Question: Produce a descriptive caption suitable for publication.
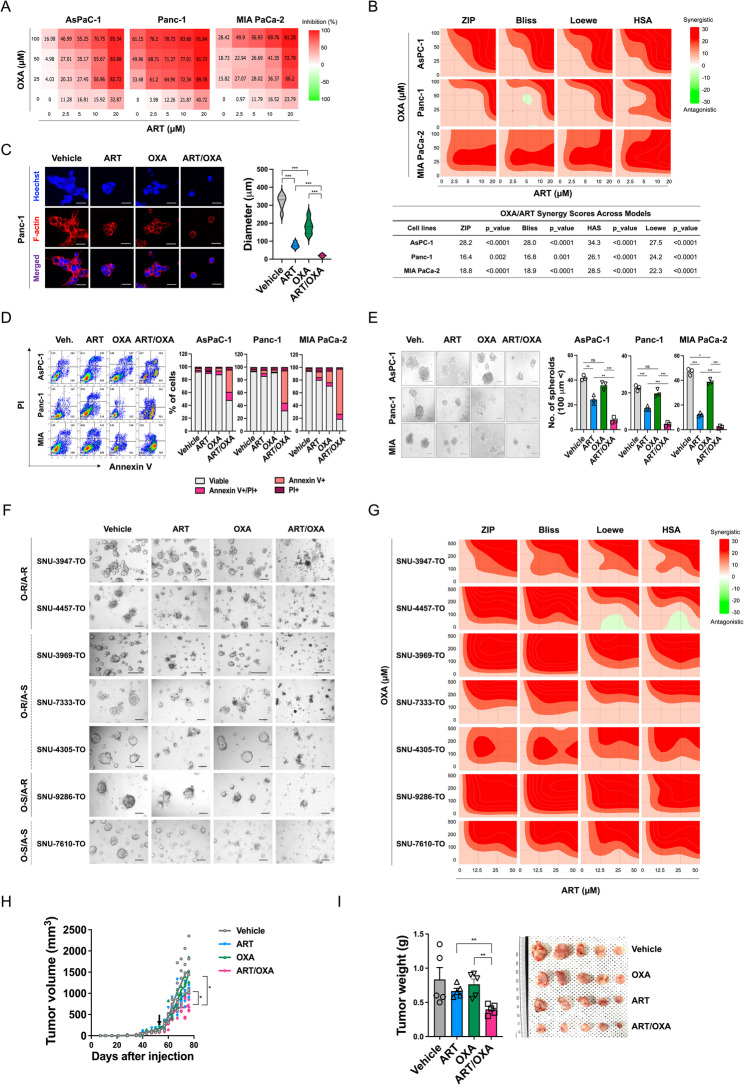
Answer: Oxaliplatin and artesunate synergize to suppress cancerous effects pancreatic cancer growth in vitro and in vivo. A Cell viability matrices showing the dose-dependent effects of OXA (0–100 µM) and ART (0–20 µM) combinations on AsPC-1, Panc-1, and MIA PaCa-2 cells over 48 h. The color scale indicates percent inhibition. B Synergy maps for OXA/ART combinations generated using ZIP, Bliss, Loewe, and HSA scoring, with corresponding synergy and statistical significance scores. C Representative images and quantification of cancer cell metastasis in 3D Matrigel models treated with vehicle, OXA (100 µM), ART (10 µM), or their combination for 48 h (nuclei: blue; F-actin: red). D Annexin V/PI flow cytometry shows cell death profiles following 48-h treatment with vehicle, OXA (100 µM), ART (10 µM), or combination. Representative flow cytometry plots and quantification of viable, early apoptotic, and late apoptotic/necrotic populations. E Spheroid formation capacity in 3D culture after 5-day treatment with vehicle, OXA (50 µM), ART (5 µM), or combination, with representative phase-contrast images and quantification. F Representative phase-contrast images of PDPCOs treated with the vehicle, ART (10 µM), OXA (200 µM), or combination for 5 days. G Synergy maps for OXA (0–500 µM) and ART (0–50 µM) combinations treated for 5 days across multiple PDPCOs analyzed using SynergyFinder 2.0. Four different synergy scoring models (ZIP, Bliss, Loewe, and HSA) were applied to quantify drug interactions. The color scale indicates synergistic (red) to antagonistic (green) effects. H Tumor growth curves of SNU-4425-TO xenografts treated with vehicle, ART (20 mg/kg, i.p., daily), OXA (5 mg/kg, i.p., twice weekly), or combination ( n = 5 mice/group). Individual mouse data points are shown with mean values connected by lines. I Final tumor weight and representative images of excised tumors from each treatment group. Quantitative data are presented as mean ± SEM with individual data points overlaid